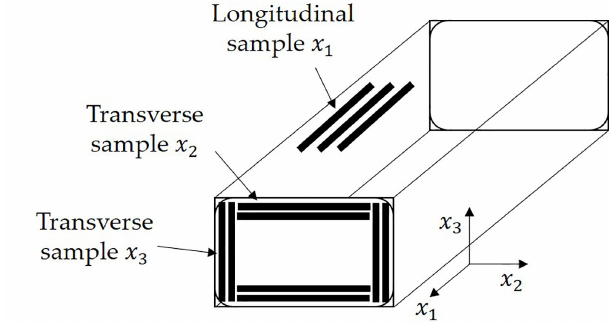
Figure 3. Samples taken from various sections of the crosstie to measure the longitudinal and transverse tensile